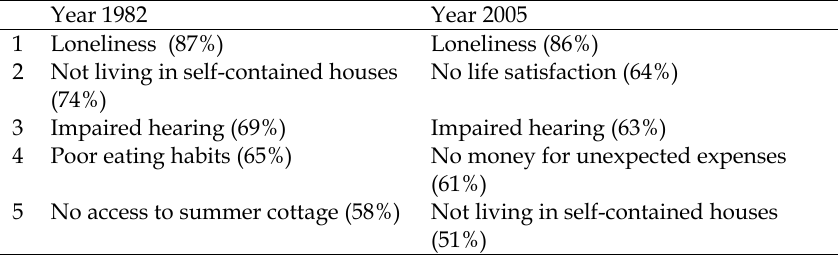
Table 2 . Rank order of stereotyped images. Percent Swedes believing in the false image in